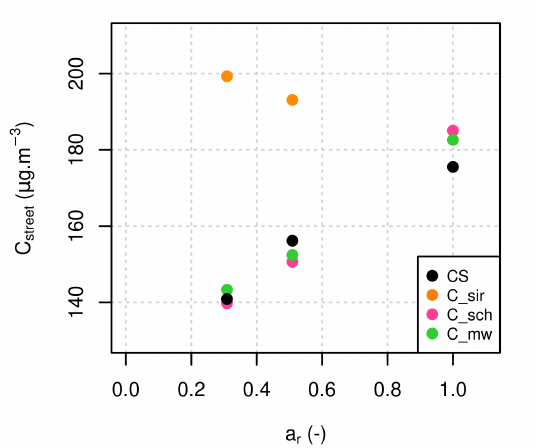
Figure A1. Comparison of average tracer concentration in the street ( C street ) between Code_Saturne (CS), Soulhac et al. [22] (C_sir), Schulte et al. [39] (C_sch) and modified Wang [37] (C_mw) depending on a r and for ϕ = 90 ◦